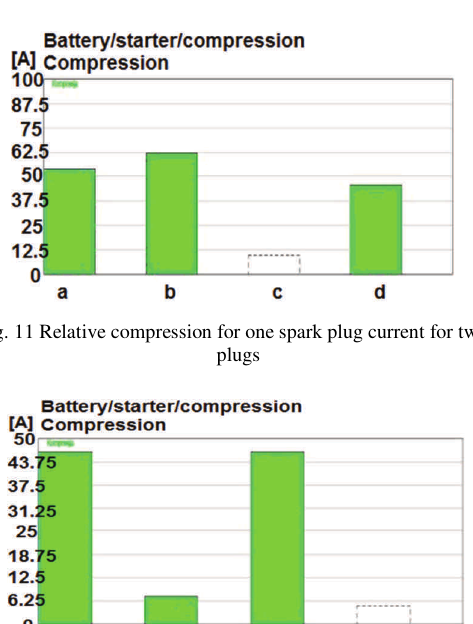
Fig. 9. Relative compression for all spark plugs